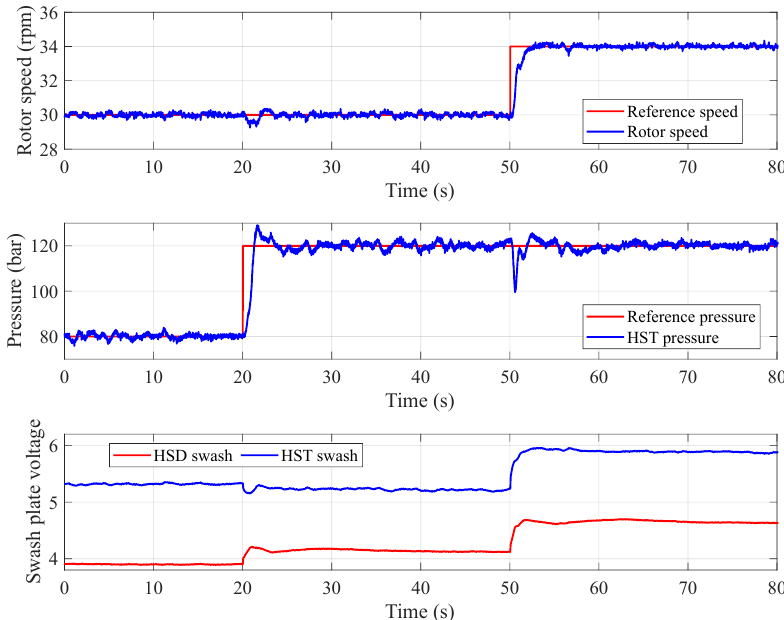
Figure 10. HST pressure and rotor speed with respect to the step